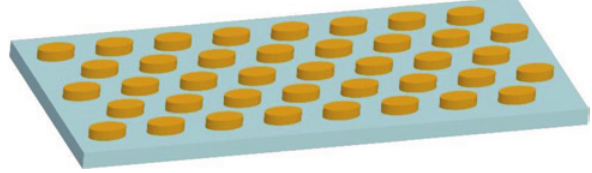
Figure 9: Substrate consisting of ellipsoidal particles in a hexagonal